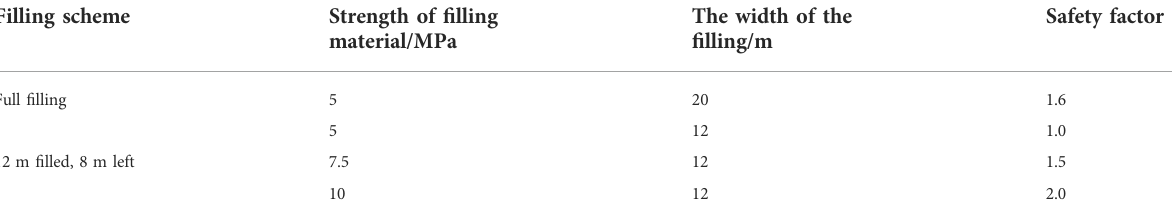
TABLE 1 Safety factors for different mining schemes. Filling